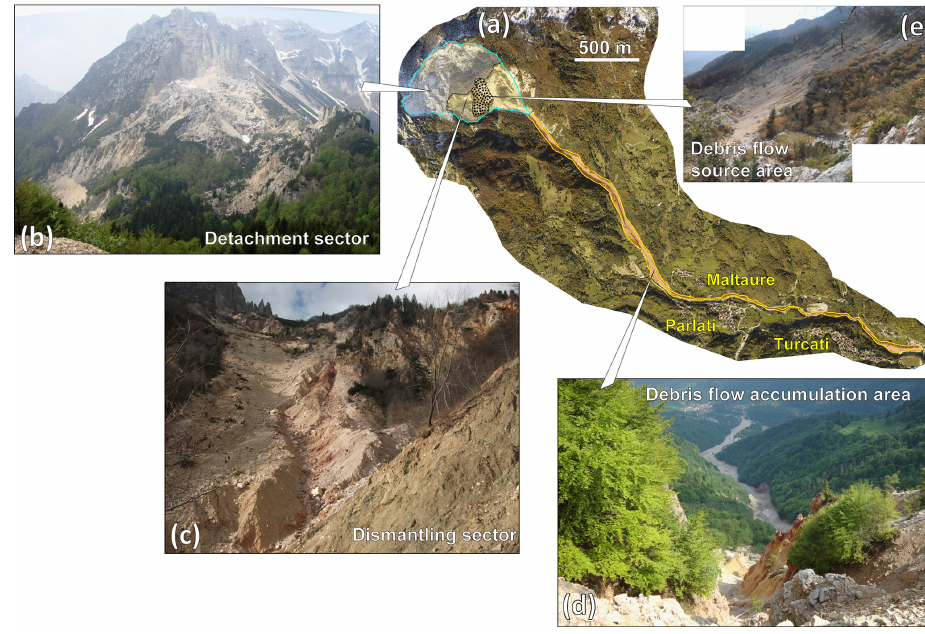
Figure 2. The Mt. Rotolon DSGSD plan (a) : landslide sectors (b, c) and the 2010 debris flow features (d, e)